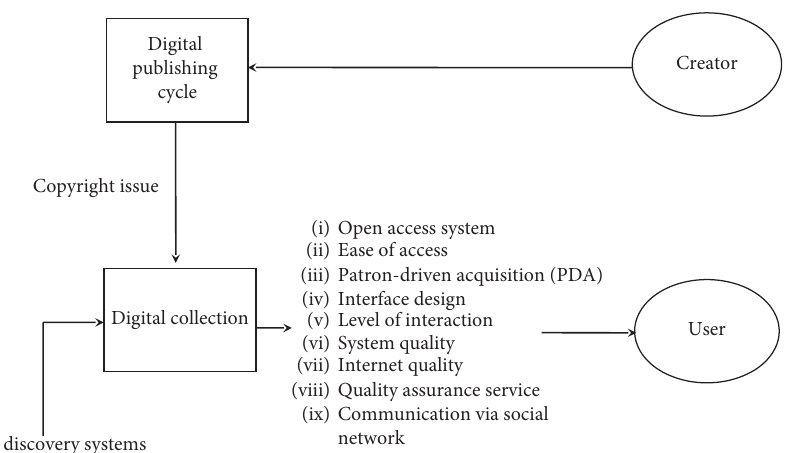
Figure 2: Proposed design of digital library